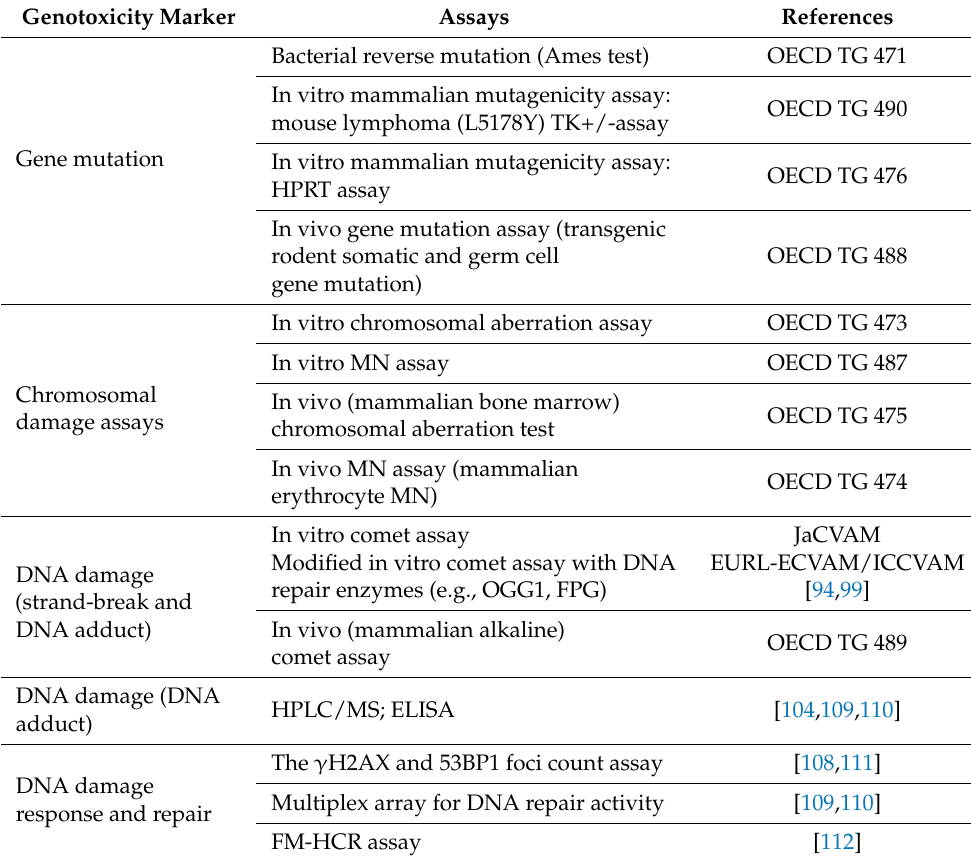
Table 2. Current testing strategies for nanomaterial-induced genotoxicity assessment. Genotoxicity